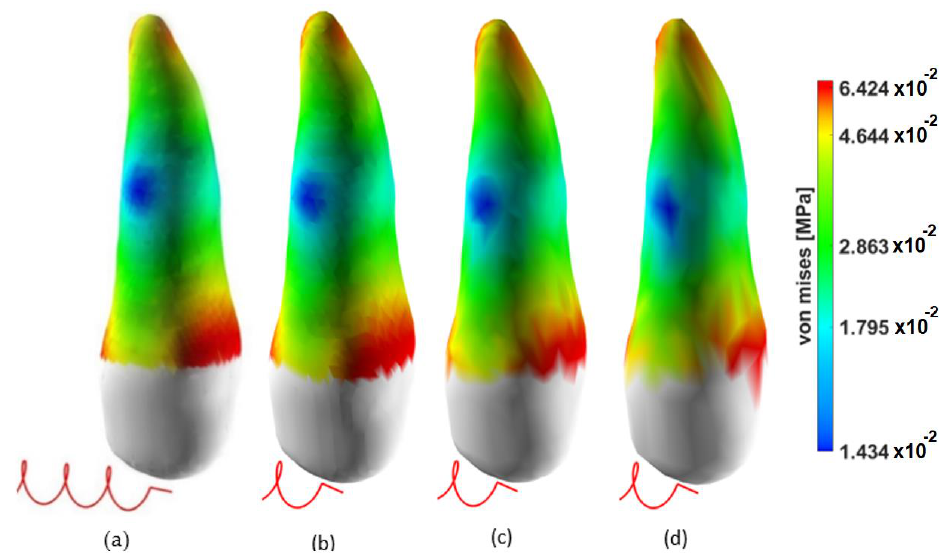
Figure 4. Upper right canine facet number optimization as OTM initiated before the remodeling process was ongoing. The red spiral represents the external force. ( a ) 26,608 facets, ( b ) 6652 facets, ( c ) 1662 facets and ( d ) 830 facets.